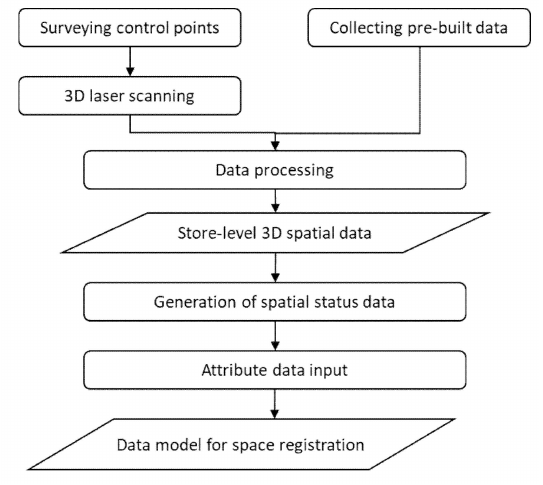
Figure 1. Processes used in this